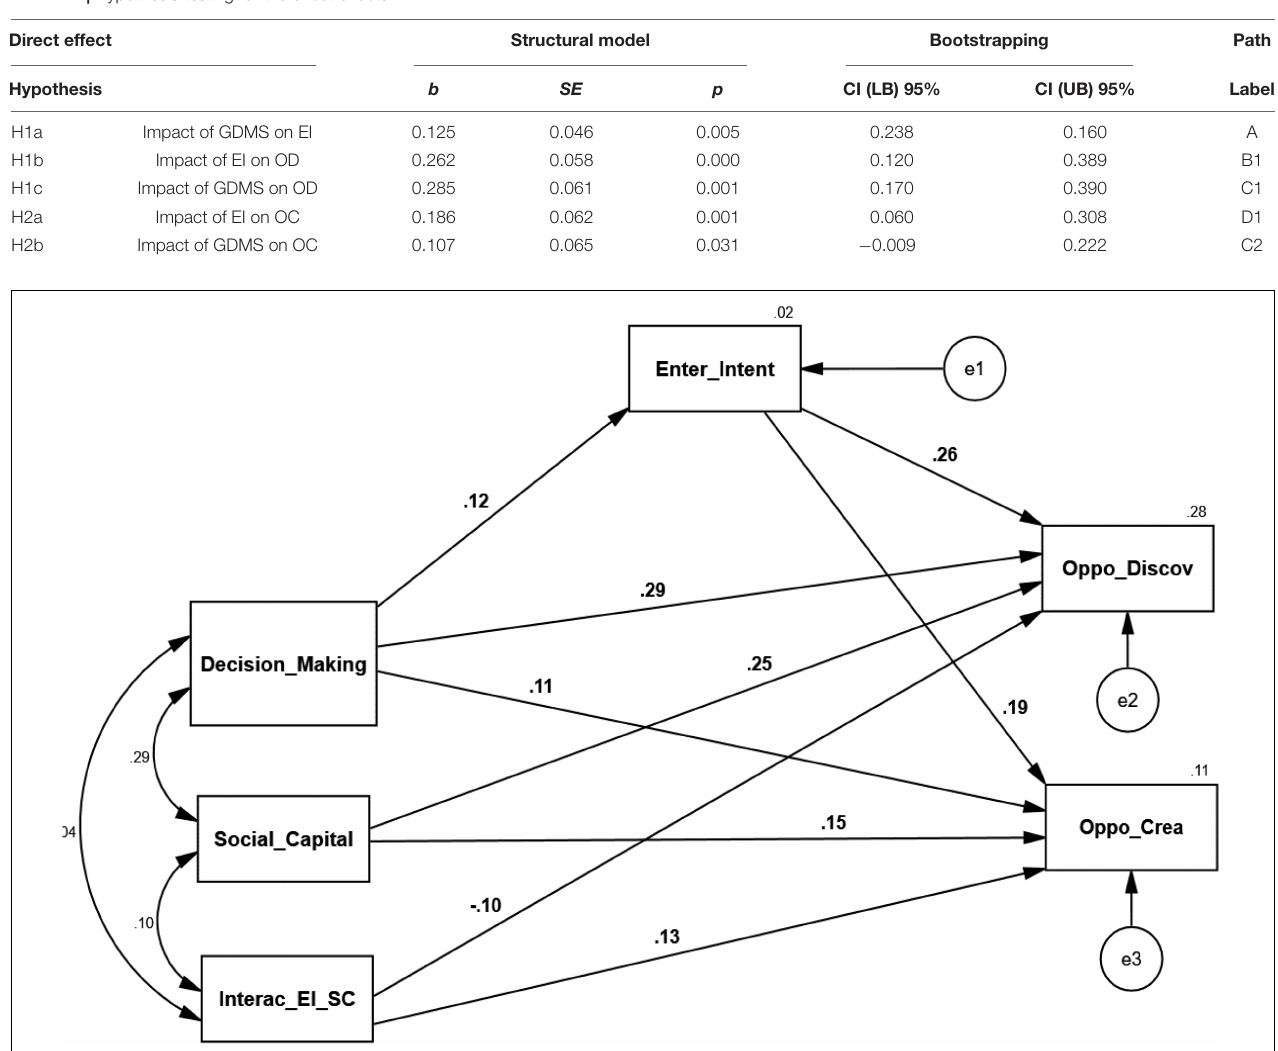
FIGURE 3 | Structural